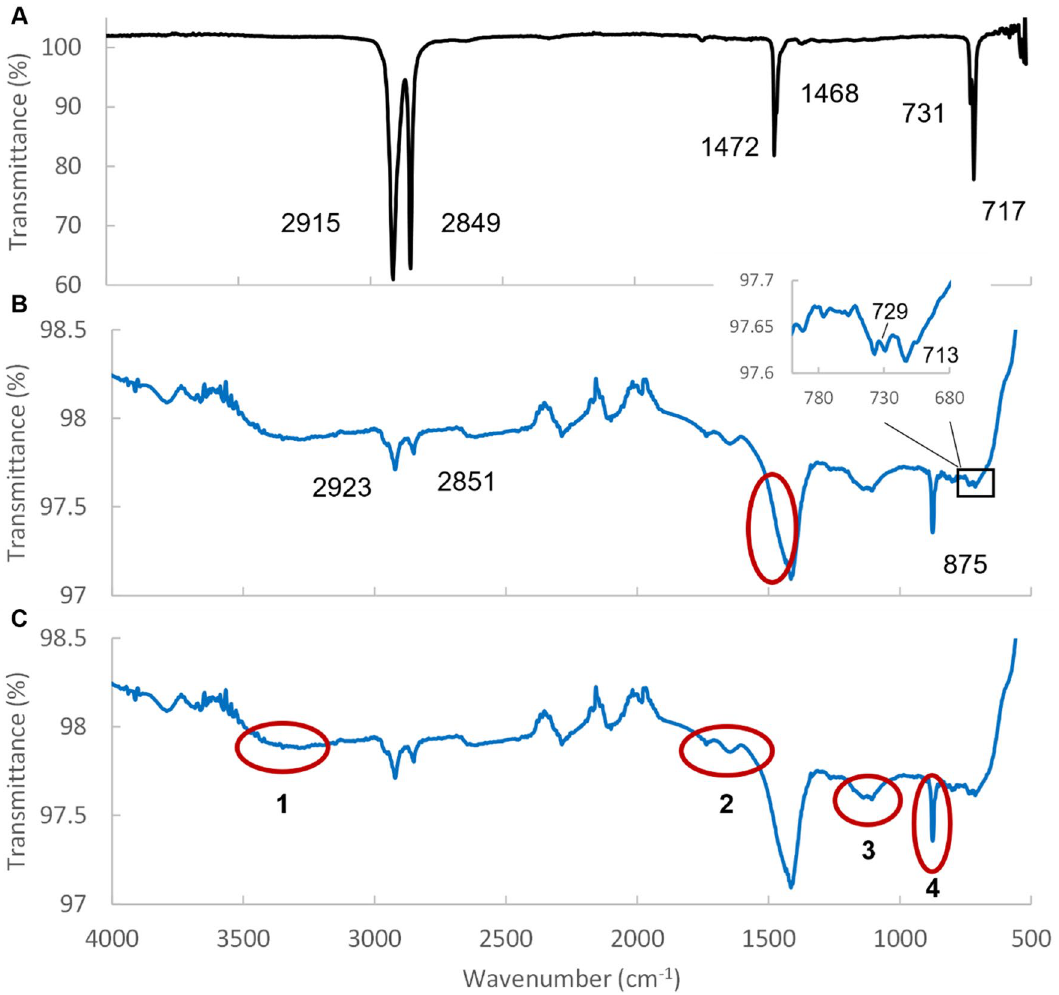
Figure 5. ATR-FTIR spectra of intact HDPE and PEVF. Spectra from the HDPE bag that was used as starting material for the breakdown process ( A ). Spectra from 10 times concentrated PEVF with the signature minima for either HDPE ( B ) or indicative for oxidation ( C ) marked in red circles.